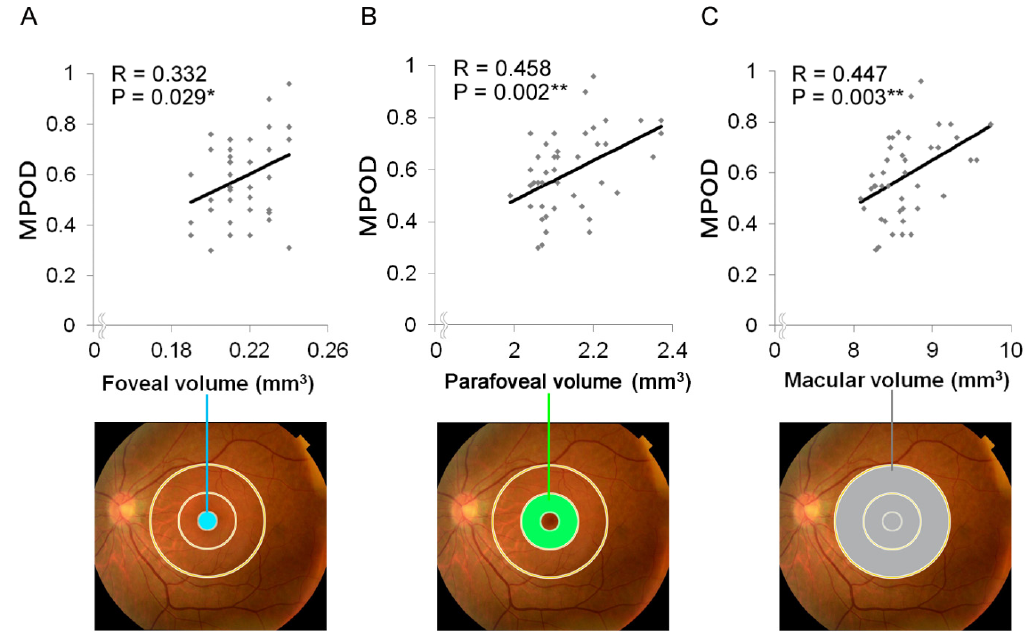
Figure 2. Correlations of the foveal, parafoveal, and macular volumes with the macular pigment optical density (MPOD). MPOD positively correlated with the retinal neural volumes of the fovea (1-mm diameter shown in blue; P = 0.029, R = 0.332, A), parafovea (1–3-mm diameter shown in green; P = 0.002, R = 0.458, B), and macula (6-mm diameter shown in gray; P = 0.003, R = 0.447, C). * P < 0.05, ** P < 0.01.